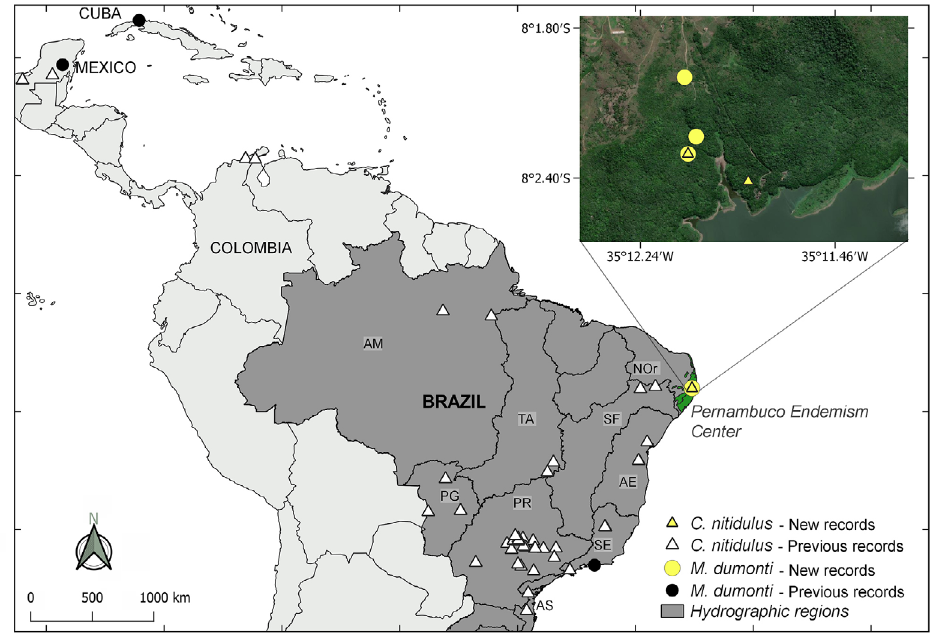
Figure 1. Distribution records of Moina dumonti Kotov, Elías-Gutiérrez and Granado-Ramírez, 2005 and Chydorus nitidulus (Sars, 1901) in Neotropical